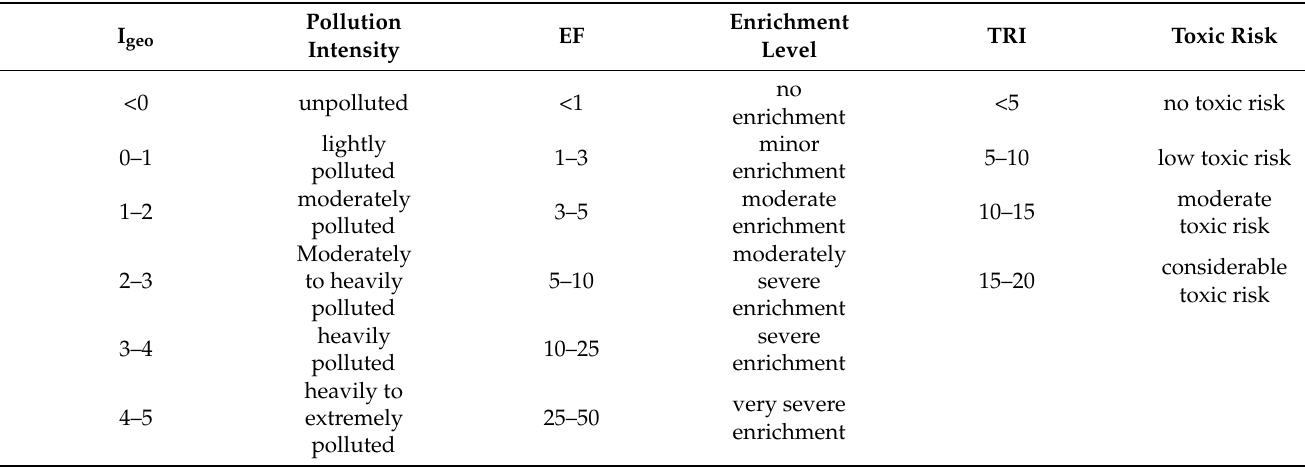
Table 3. Contamination and toxic risk categorizations based on the geo-accumulation index (I geo